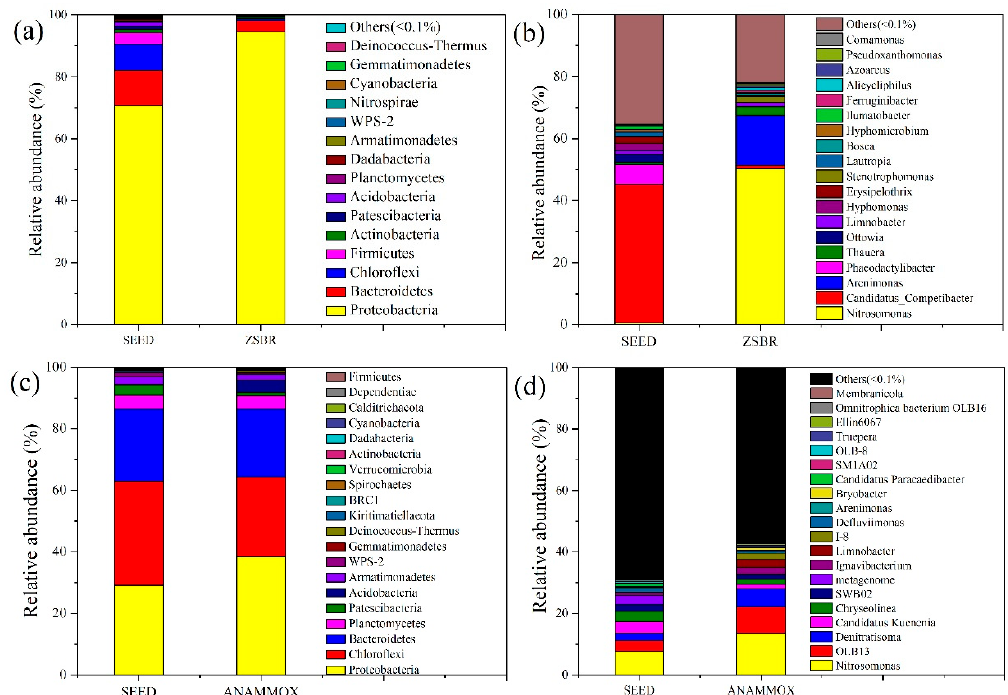
Figure 6. Taxonomic classification of the bacterial communities for SEED and 56 cycles in the zeolite sequencing batch reactor at ( a ) phylum level and ( b ) genus level; taxonomic classification of the bacterial communities for SEED and day 70 in the up-flow blanket filter at ( c ) phylum level and ( d ) genus level.